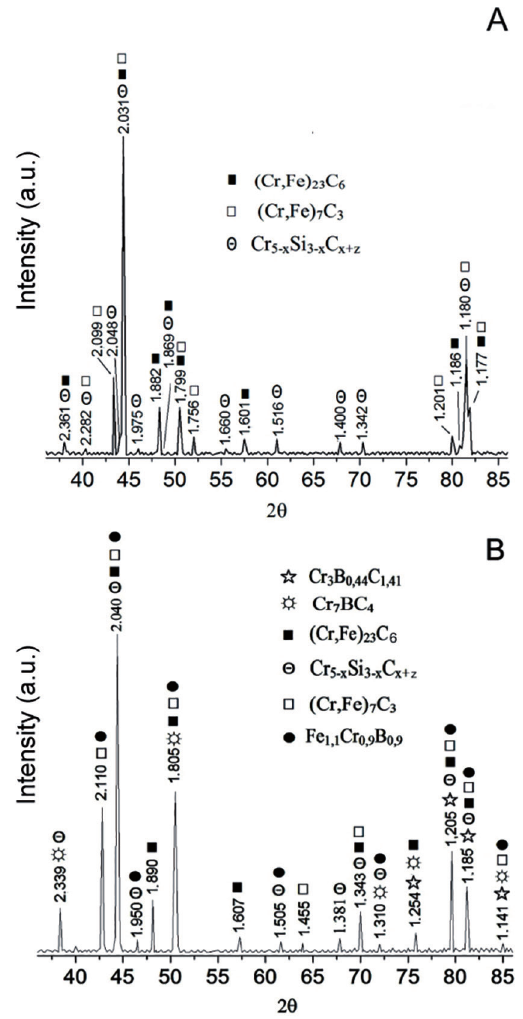
Figure 4: XRD diffraction patterns of the coatings. A) - Chromizing and B) - Chrome–boronizing–siliconizing (obtained using the mixture